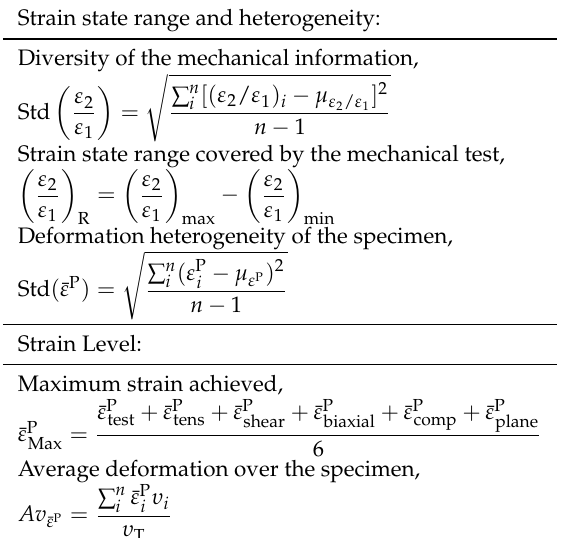
Table 3. Terms that define the indicator I T . Data from [12]. Strain state range and heterogeneity: